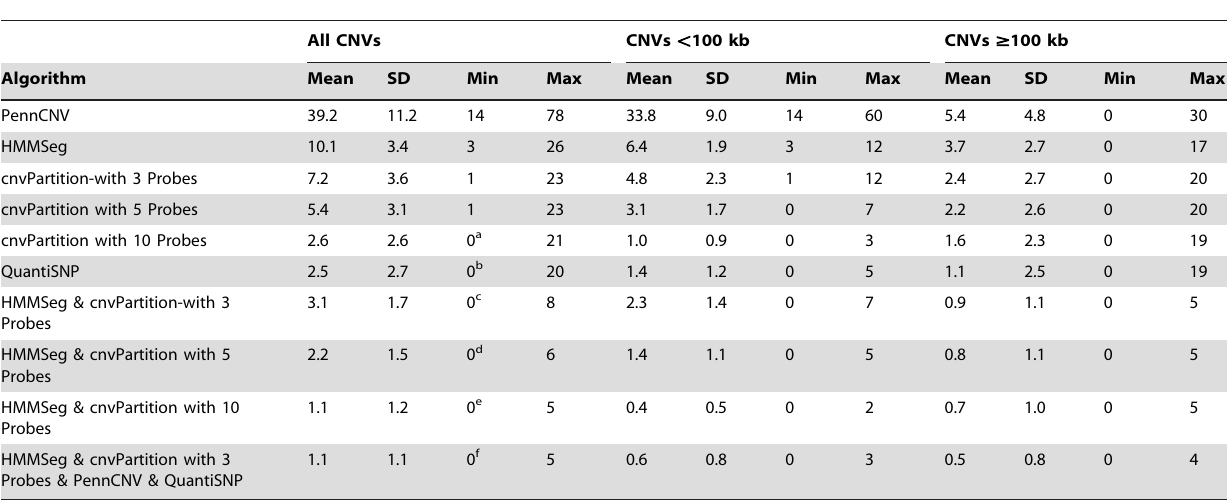
Table 4. Number of CNVs per person detected in 96 subjects by each algorithm.